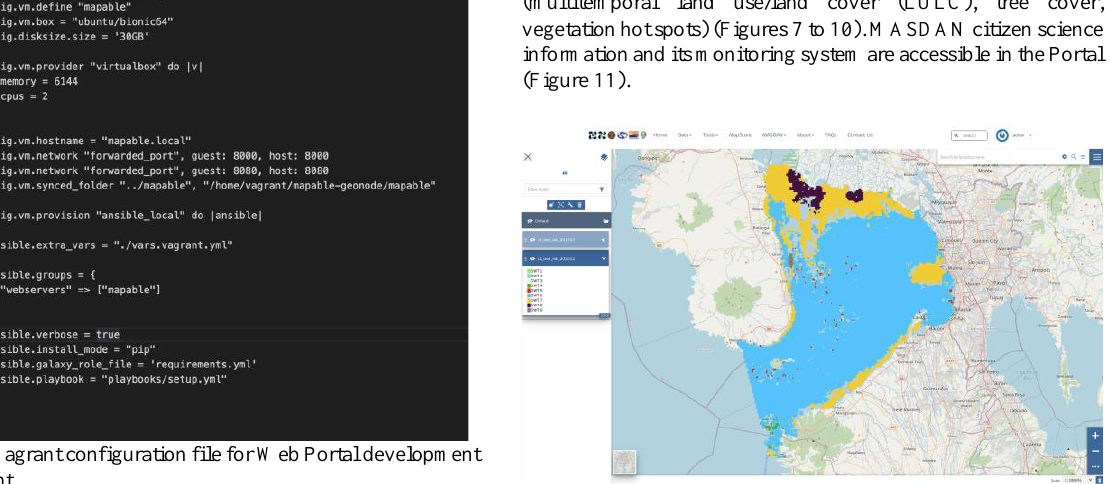
Figure 7. December 2020 OWT map of Manila Bay. Sentinel-3 data acquired from European Organisation for the Exploitation of Meteorological Satellites (EUMETSAT) EO Portal are processed using Sentinel Application Platform (SNAP) OWT Tool.